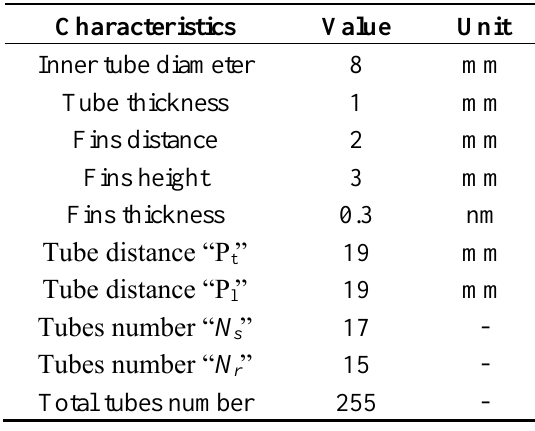
Table 12. Geometric characteristics of R245fa component.